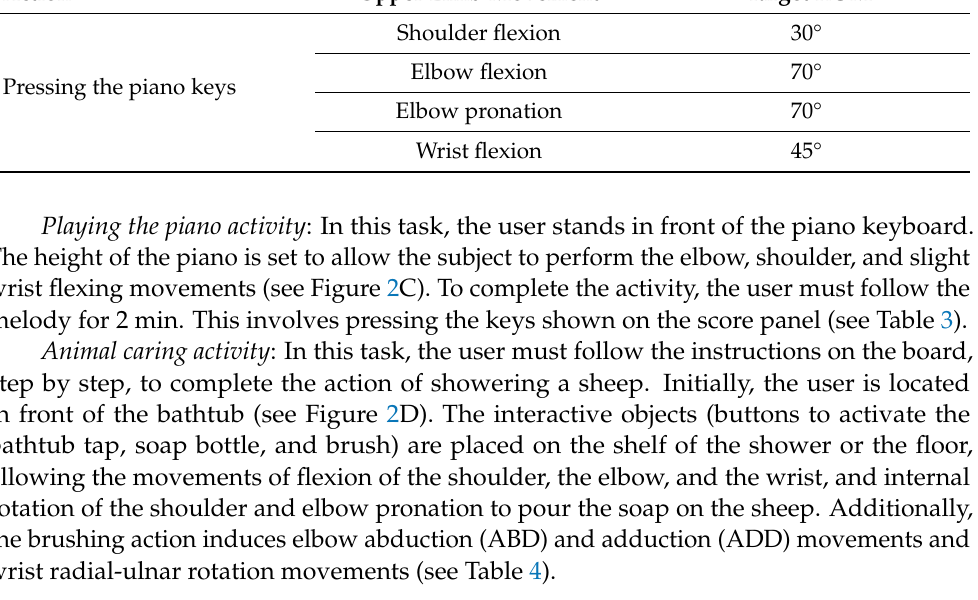
Table 3. Sequence of actions and the upper limb movements involved in the playing piano activity. Action Upper Limb Movement Target ROM Shoulder flexion 30° Elbow Pressing the piano keys